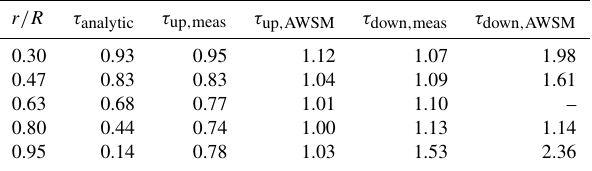
Table 1. Time constants (in seconds) from measurements, AWSM calculations and a cylindrical wake model from Schepers (2007). The forces predicted by AWSM at the 63% radial station for the downward pitching step did not exhibit clear exponential behavior, and therefore no time constant could be